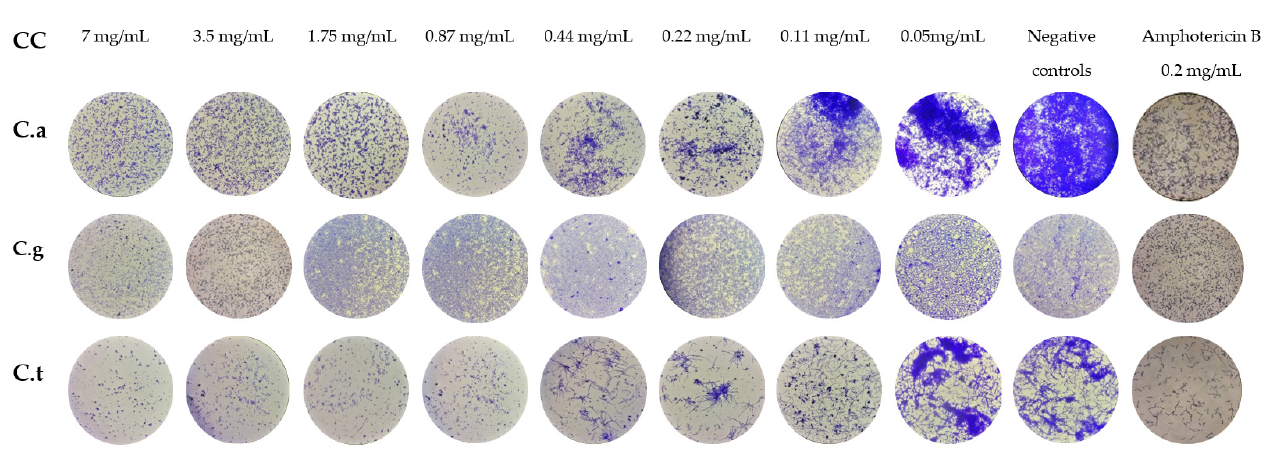
Figure 4. Micrographs of Candida spp. cells treated with various concentrations of VF1 for Inhibition of Biofilm Formation (IBF). CC: Concentration, C.a: Candida albicans , C.g: Candida glabrata . C.t: Candida tropicalis.